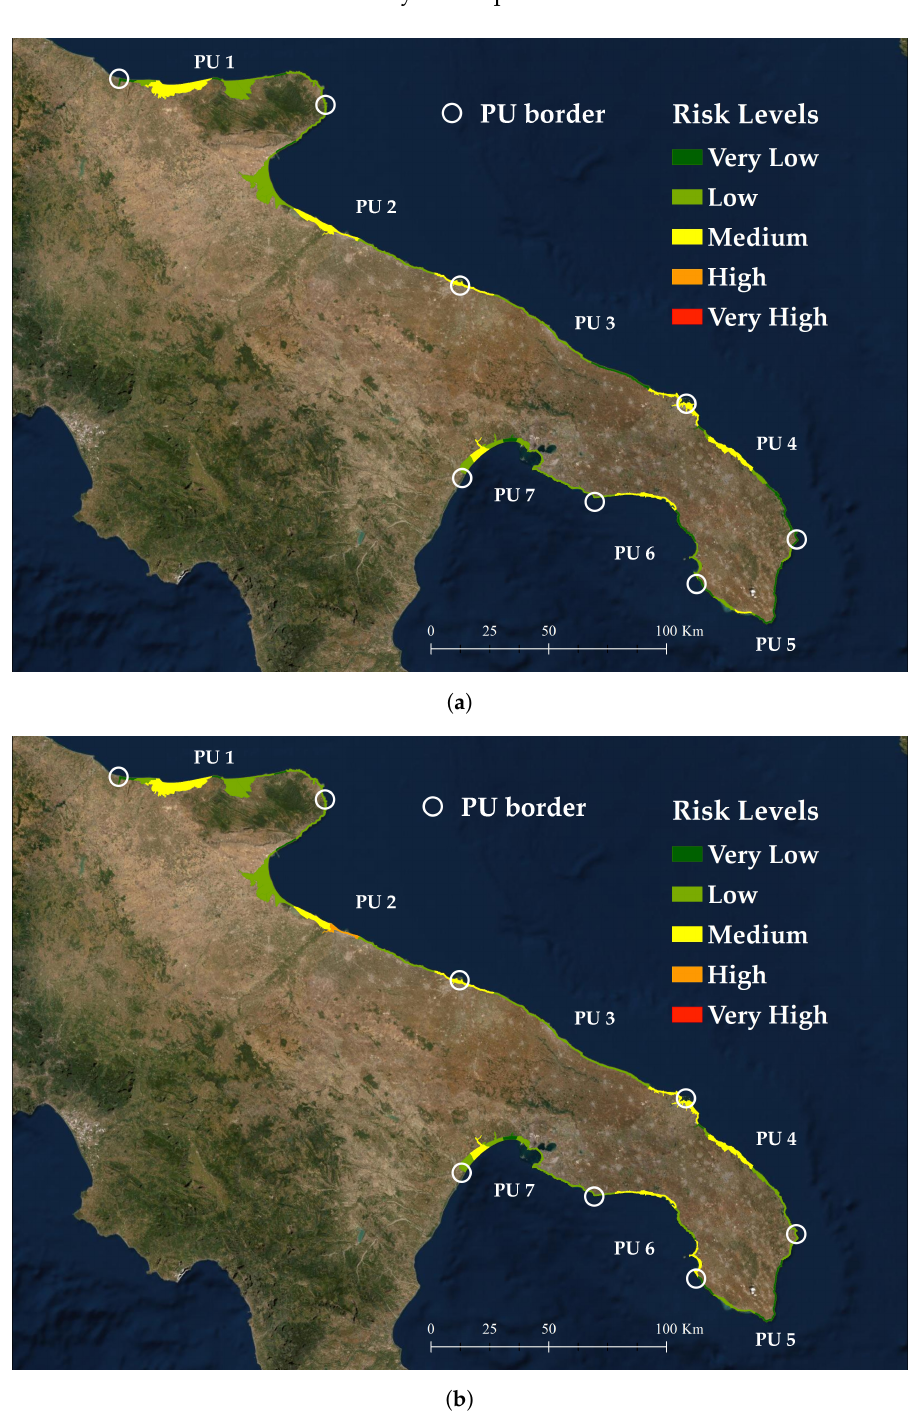
Figure 5. Normalized Risk Levels for all Apulian municipalities estimated using: ( a ) EUrosion model; ( b ) modified EUrosion model: present-day values. The satellite image is from